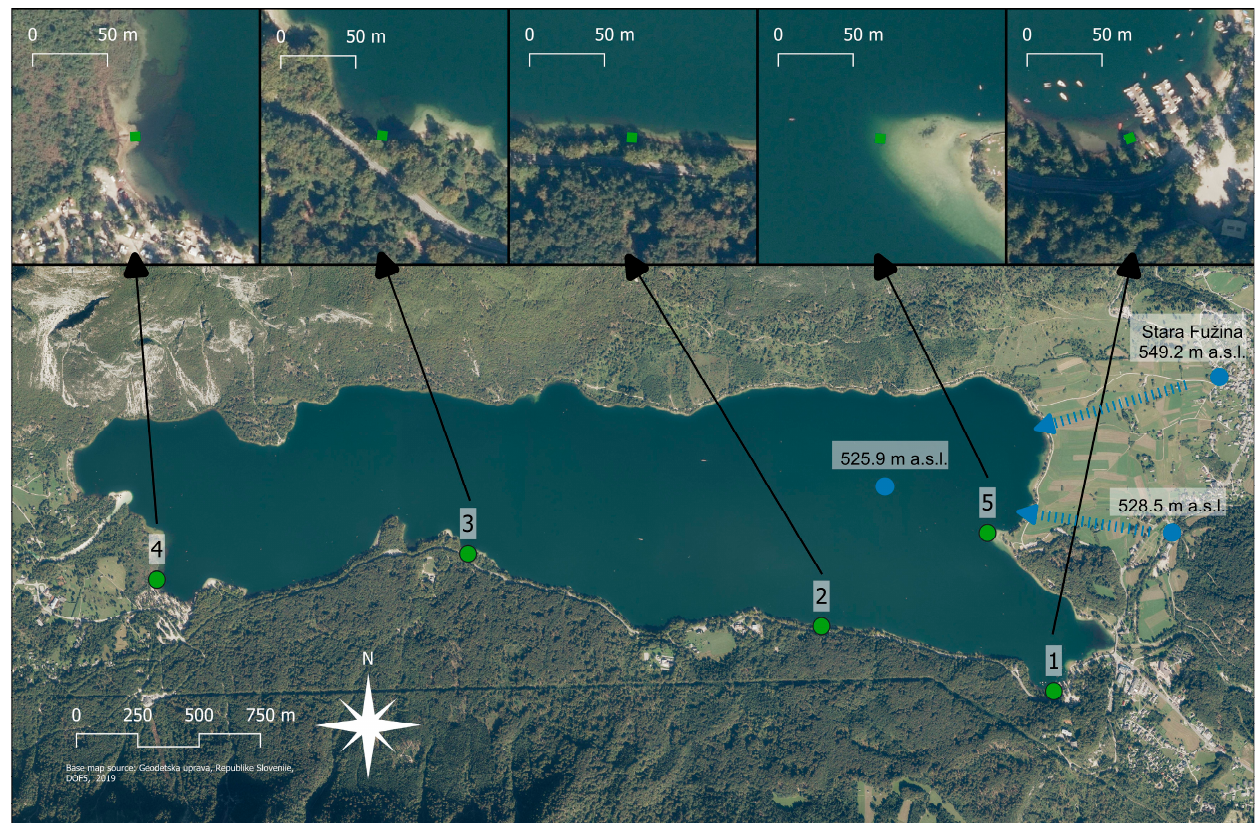
Figure 1. A map showing the location of the sampling plots in Lake Bohinj. Pictures on the upper site represent the size of each sampling plots with a dimension 6 × 6 m. The area east of the lake (and sampling plot 5) is a front-moraine of the former glacier reaching towards the village of Stara Fužina, where iron-ore smelting activities occurred. Blue circles show the altitude of the specific area, while blue arrows display the directions of the subsurface water currents. Table 1. List of species collected in each plot. Plot Species